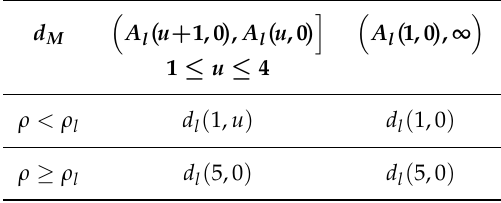
Table 7. Optimal solutions to Problem 2 with respect to the tumor parameter ρ and the value of d M for prevalent late constraint.